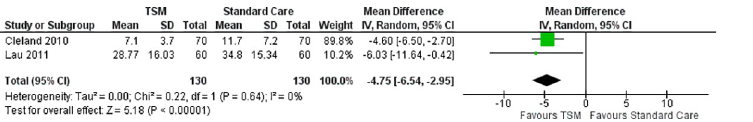
Fig 9. Meta-analysis for TSM versus standard care for disability at long-term follow-up.